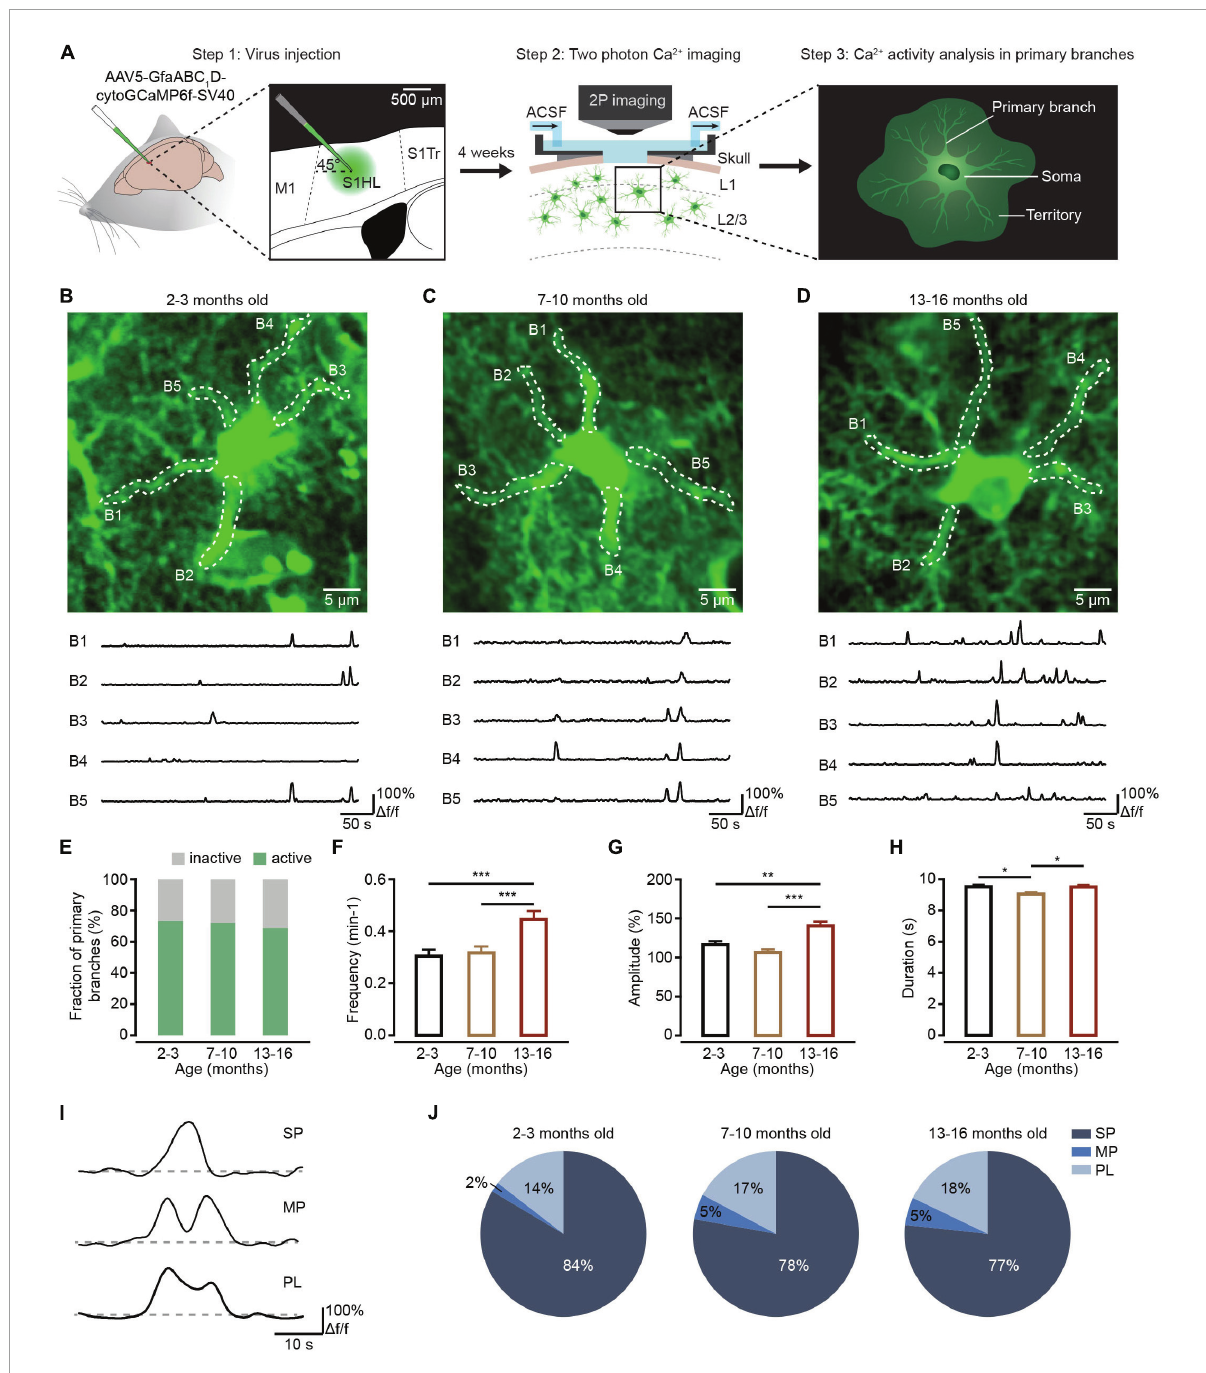
FIGURE1 Ca 2 + transient changes within primary branches of cortical astrocytes during brain aging. (A) Experimental flow diagram. Left: AAV5-GfaABC 1 D-cytoGCaMP6f-SV40 was injected into the S1 area. Middle: in vivo two-photon Ca 2 + imaging was performed on the cortical astrocytes 4 weeks after viral injection. Right: in vivo Ca 2 + transients were analyzed in primary astrocyte branches. (B–D) Top, representative two-photon images of GCaMP6f-labeled astrocytes in the 2–3-month-old ( B ; imaging depth, 110 µ m), 7–10-month-old ( C ; imaging depth, 107 µ m), and 13–16-month-old groups ( D ; imaging depth, 80 µ m). Primary branch ROIs are outlined using white dashed lines. Below are example traces of spontaneous Ca 2 + transients from each ROI. (E) The fraction of active primary branches within the 2–3-month-old ( n = 183 ROIs from six mice), 7–10-month-old ( n = 197 ROIs from nine mice), and 13–16-month-old groups ( n = 169 ROIs from six mice); all groups: χ 2 = 0.9739, P = 0.6145, χ 2 -test. (F) Bar graphs summarizing the frequencies of Ca 2 + transients within all active branches of the 2–3 month-old ( n = 129 ROIs from six mice), 7–10-month-old ( n = 141 ROIs from nine mice), and 13–16-month-old ( n = 110 ROIs from six mice) group. The 2–3-month-old group versus the 7–10 month-old group: P = 1.000; the 2–3-month-old group versus the 13–16-month-old group: